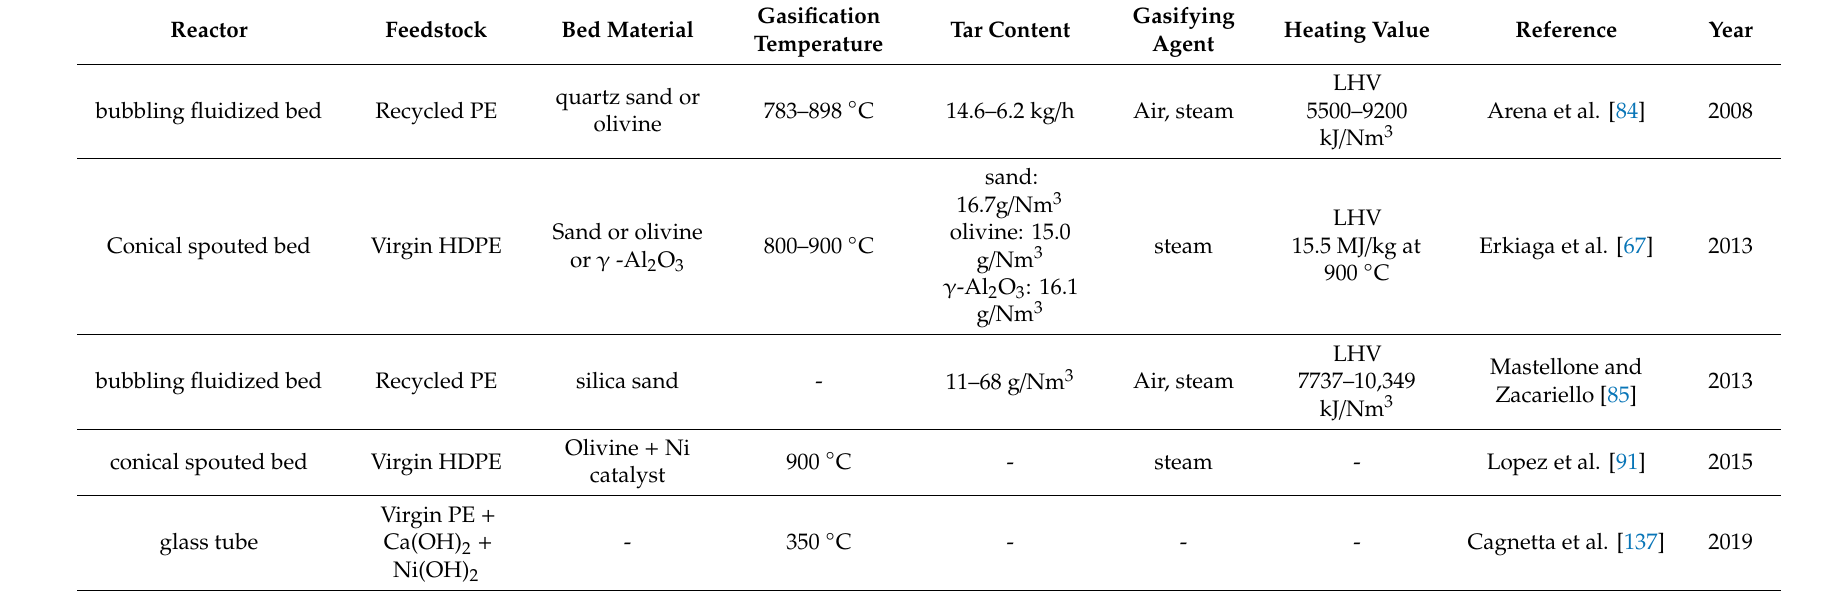
Table 4. Polyethylene gasification summary